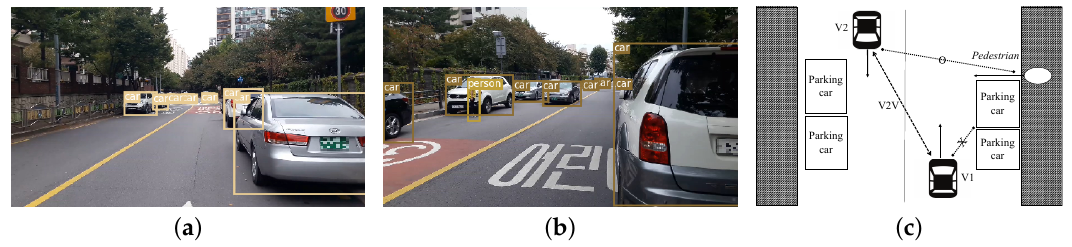
Figure 10. Collision scenario: ( a ) Front image of V1 which cannot detect a pedestrian. ( b ) Front image of V2 which can detect a pedestrian. ( c ) Top-view illustration of this